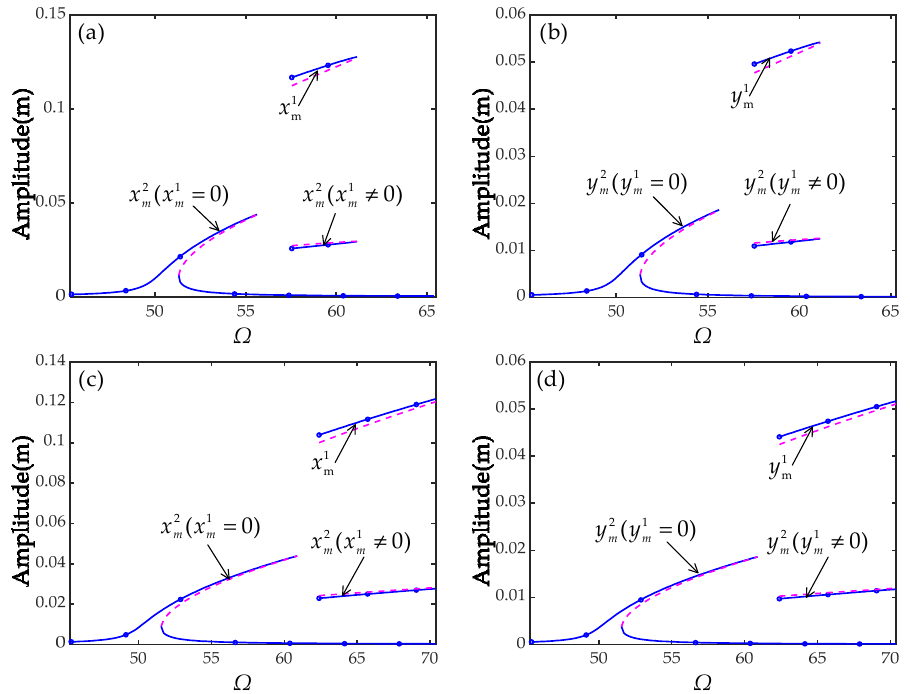
Figure 11. Frequency response curves for the second mode at Ω = ω 2 + εσ 2 , σ 1 = 0.01, F = 1.2, ( a , b ) k N = 1.2 × 10 4 N · m/rad 3 ; ( c , d ) k N = 2.4 × 10 4 N · m/rad 3